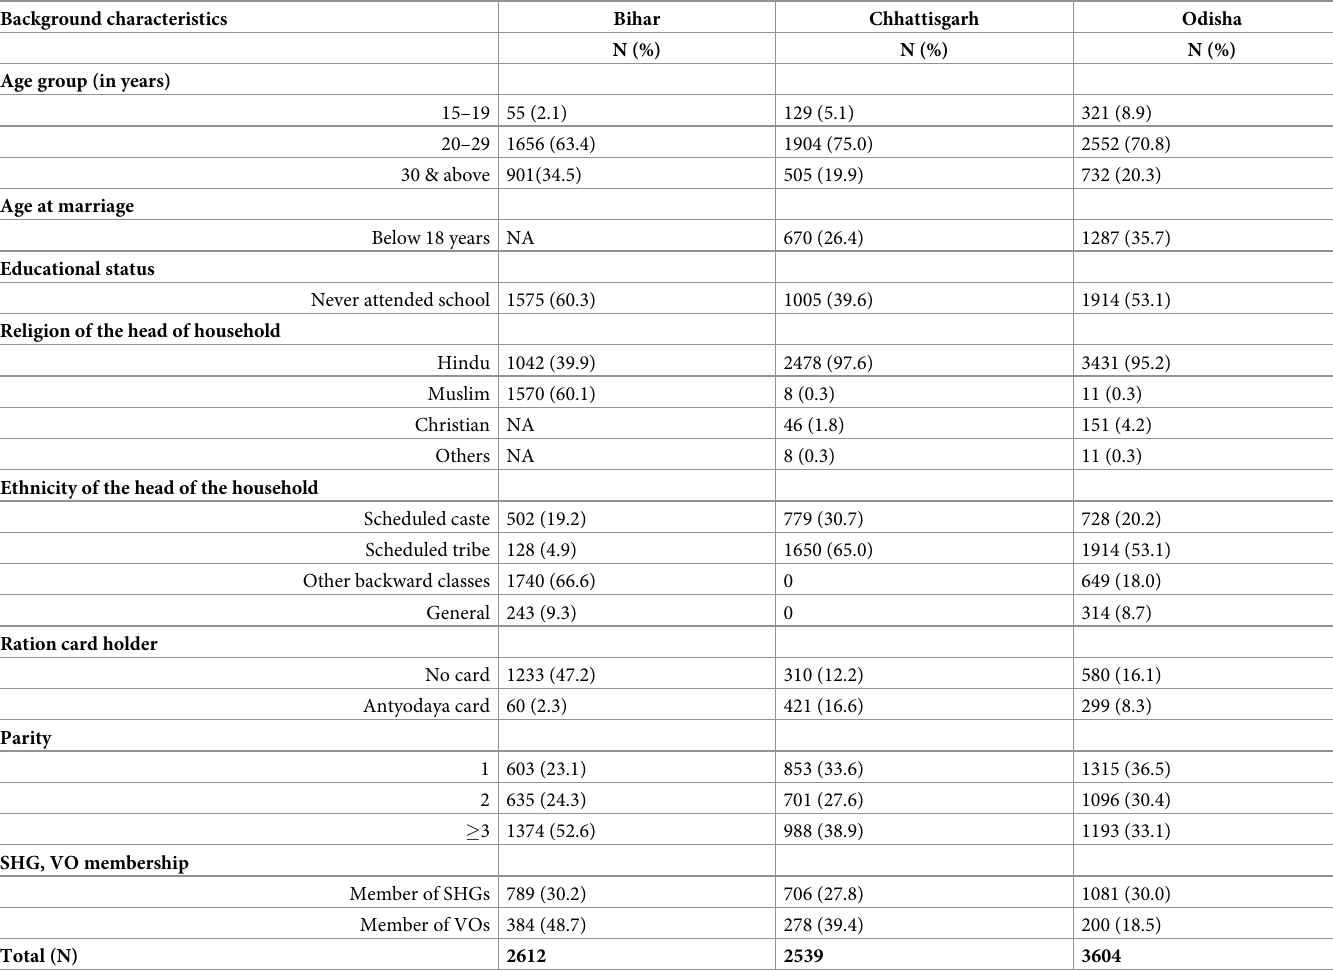
Table 4. Profile of mothers of children under-two by selected background characteristics in Bihar, Chhattisgarh and Odisha. Background